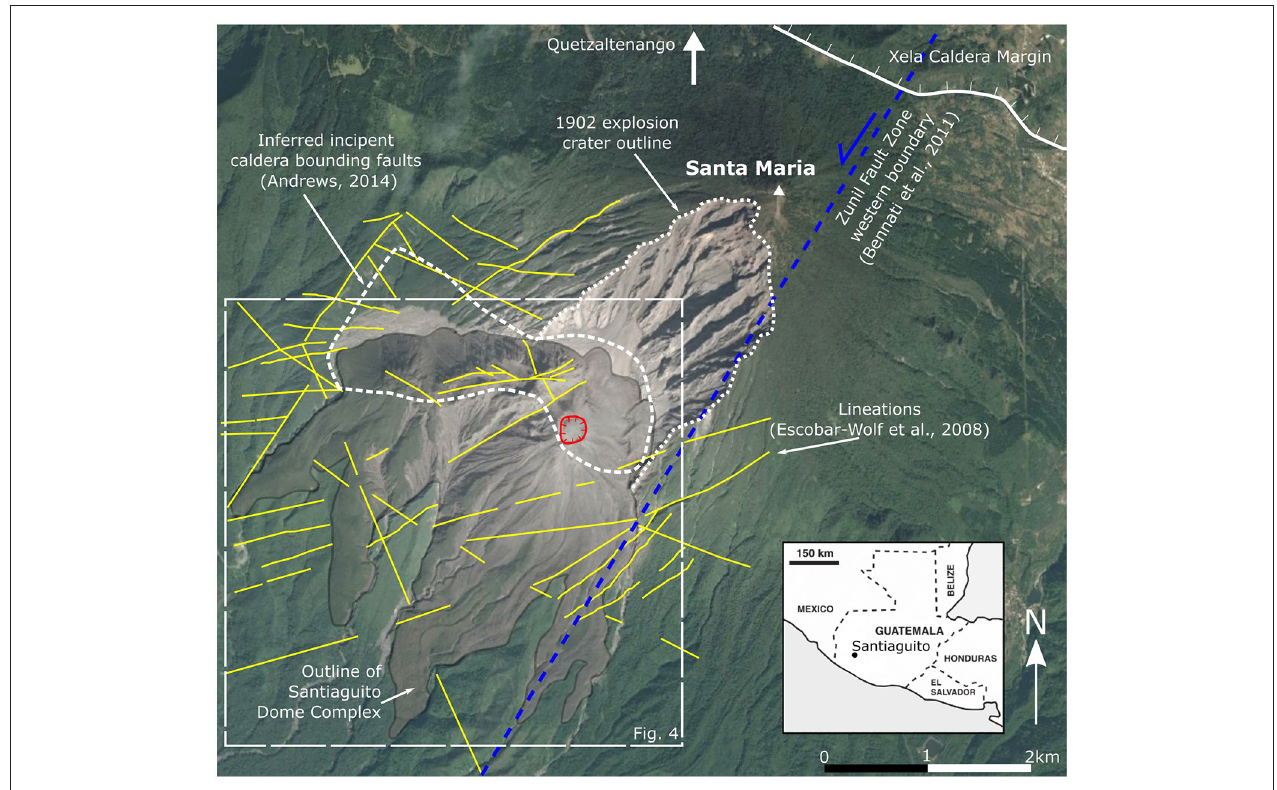
FIGURE 2 | Major structural features at Santa Maria and Santiaguito. Santa Maria lies to the south-east of the Xela Caldera Margin (84–12Ma; Duffield et al., 1993), and sits on the western margin of the Zunil Fault Zone, both mapped by Bennati et al. (2011). The ∼ 1,000m high erosional explosion crater and inferred incipient caldera bounding margin (Andrews, 2014) formed during the 1902 eruption are marked with a white dotted and dashed line, respectively. Lineations, defined by the alignment of topographic and or geomorphic features, possibly related to faults or joints, are displayed in yellow and were mapped by Escobar-Wolf et al. (2010). Santiaguito is shaded gray with the active El Caliente crater marked in red. Aerial photograph sourced from Google Map data © 2018.